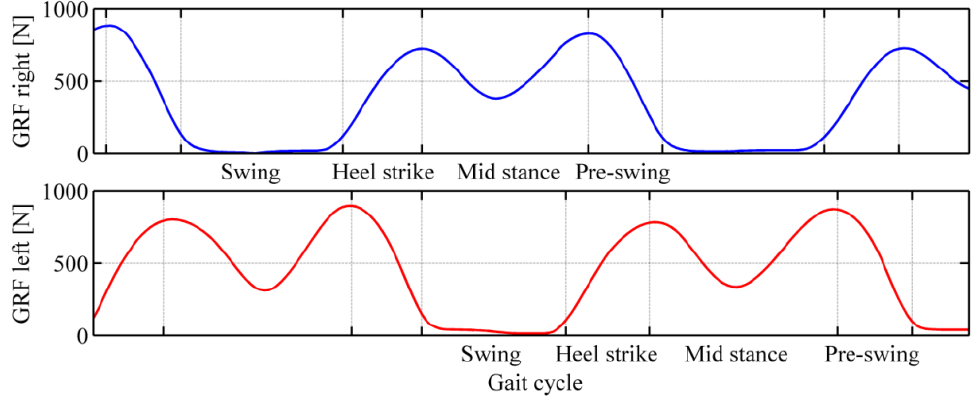
Figure 15. Gait phases recognition through the pressure-sensitive insole for both left (top panel) and right (bottom panel)